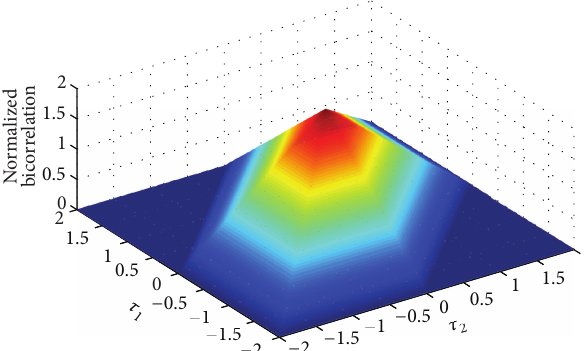
Figure 3: Zoomed C/A-GPS code bicorrelation peak presenting a hexagonal basis.